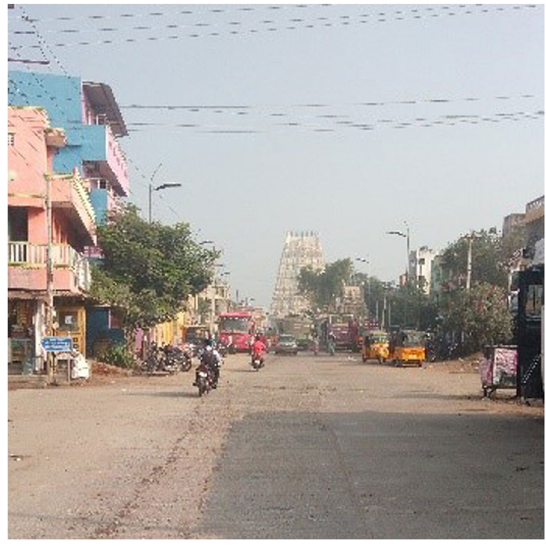
Fig. 5 Krishnan Street leading to the Ekambareswar temple (Source: the author)